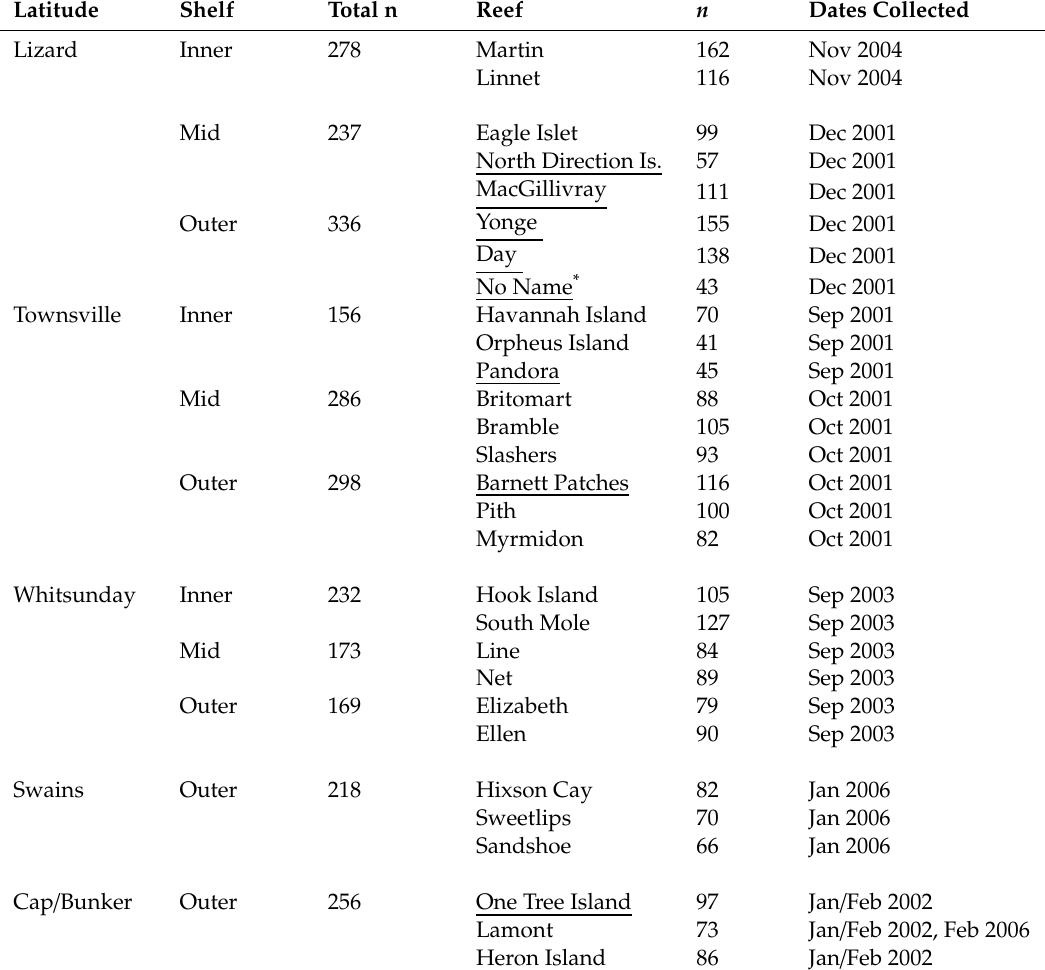
Table 1. Location and numbers of Acanthochromis polyacanthus collected from September 2001 to January 2006. The Townsville samples are those of Kingsford and Hughes [26]. Reefs are underlined if they were marine protected areas (MPAs); otherwise, they are reefs where fishing was allowed. * No Name reef was only used for Analysis